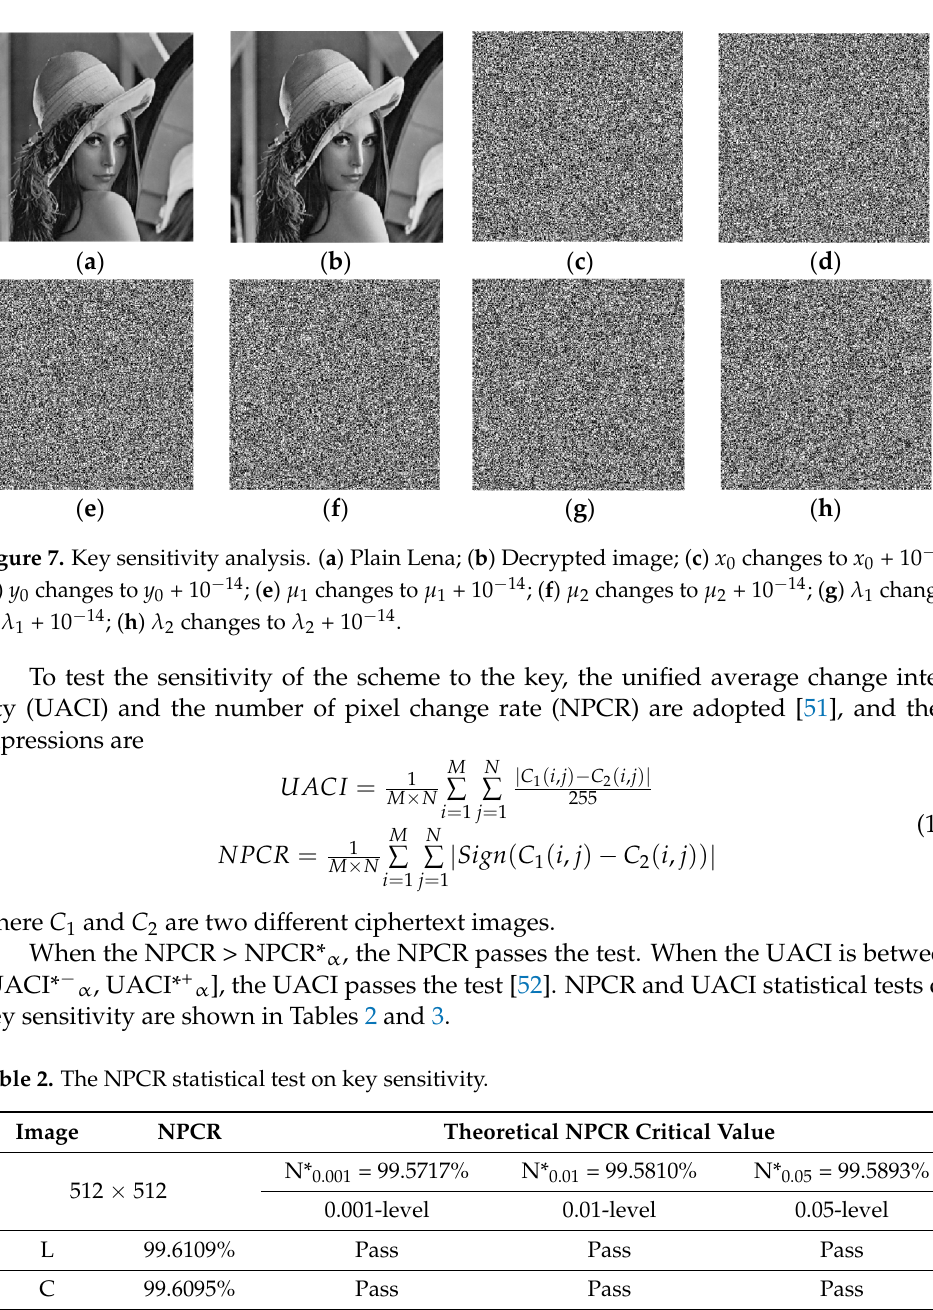
( c4 ) Figure 6. Experimental simulation. ( a1 – a4 ) Plaintext images; ( b1 – b4 ) Ciphertext images; ( c1 – c4 ) De- crypted images. 6.3. Running Time To demonstrate the utility of the scenario, the running time is presented in Table 1. The running time is acceptable, which demonstrates that the scheme is practical. Table 1. Encryption runtime (Unit: s).